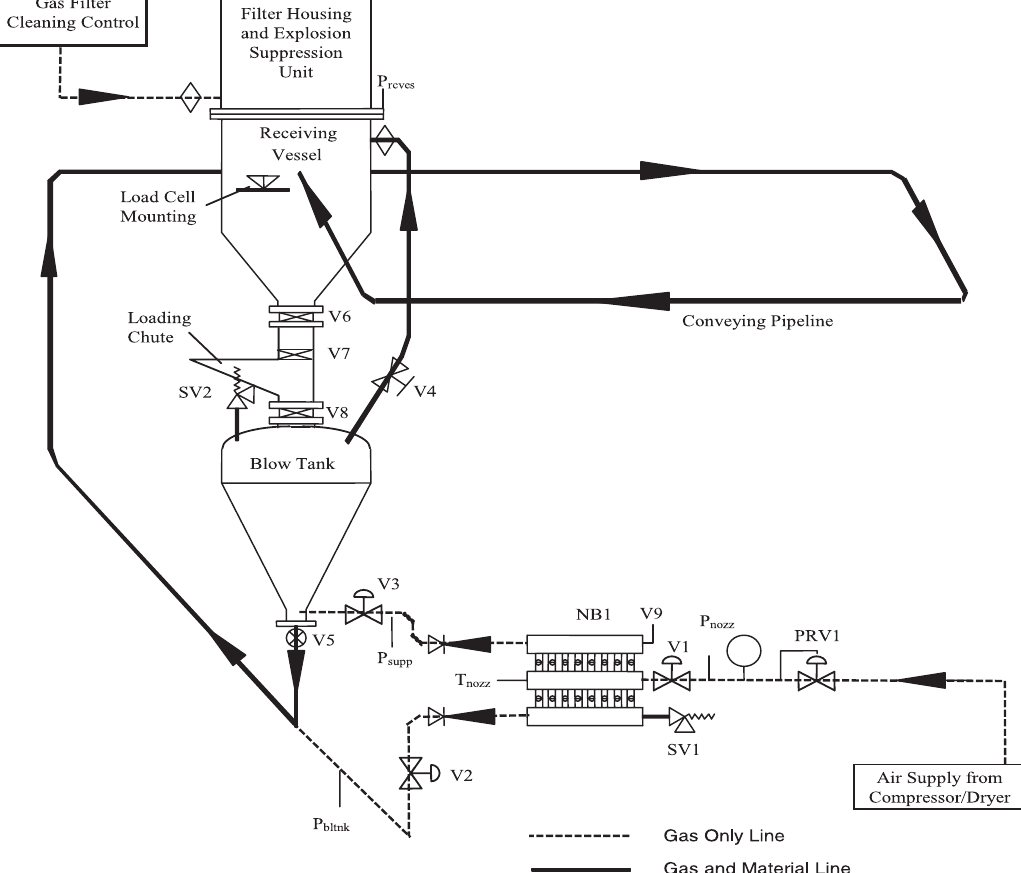
Fig. 3 Schematic diagram of industrial-scale test